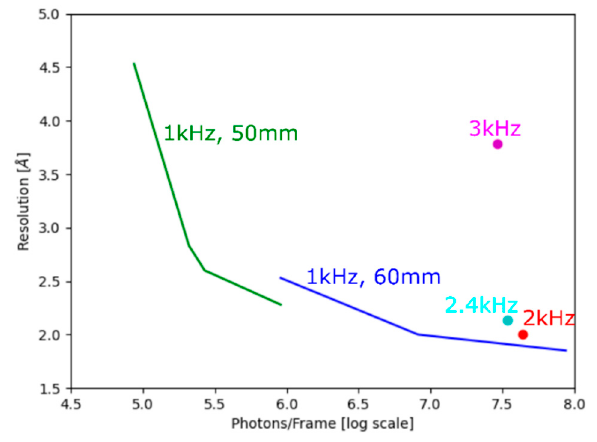
Figure 8. A plot of resolution versus the number of photons (on the crystal) per frame (see Table 1) after the analysis with the XDS and iMOSFLM programs.